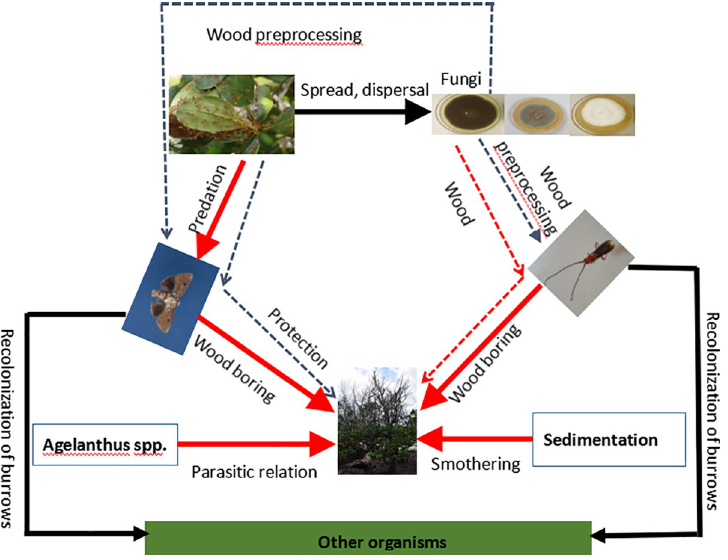
dotted lines indicate an assumed beneficial relationship between organisms, a black line indicates a relationship thought to be beneficial, red lines indicate a harmful relationship, whereas a red dotted line indicates a relationship thought to be